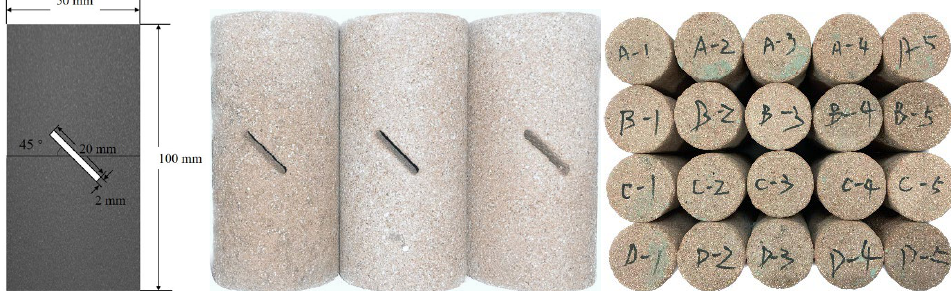
Figure 1. Schematic representation of the specimen and initial specimen diagram.